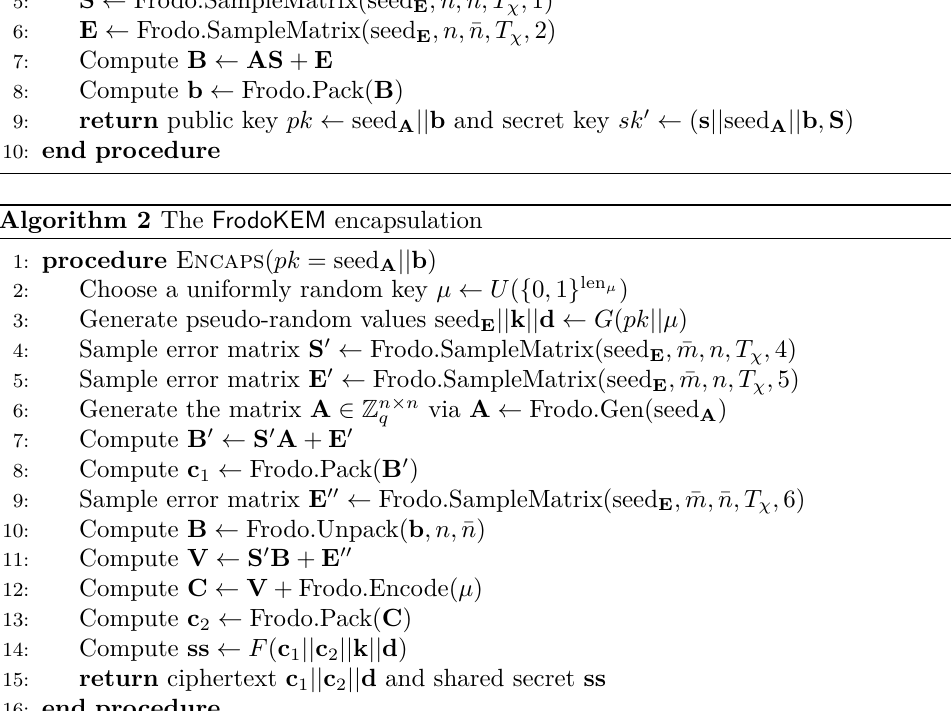
Algorithm 1 The FrodoKEM key pair generation